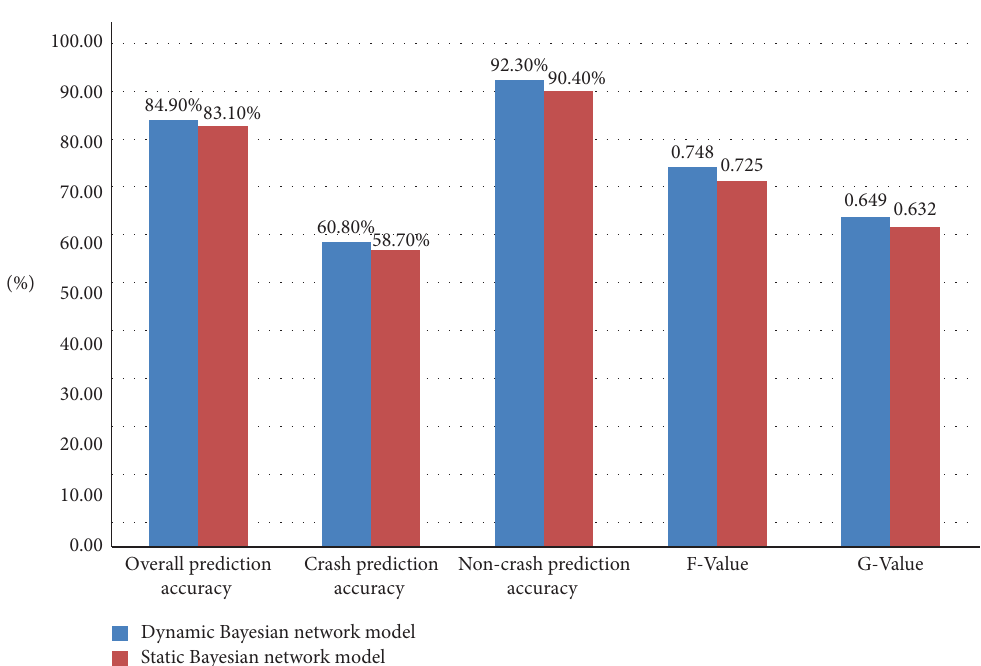
Figure 7: Prediction result comparison between dynamic Bayesian network model and static Bayesian network